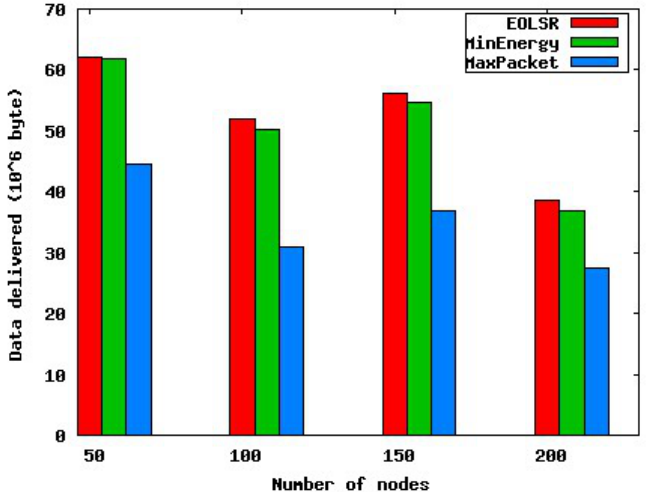
Figure 3. Comparison of the amount of data delivered with EOLSR, MinEnergy and MaxPacket.